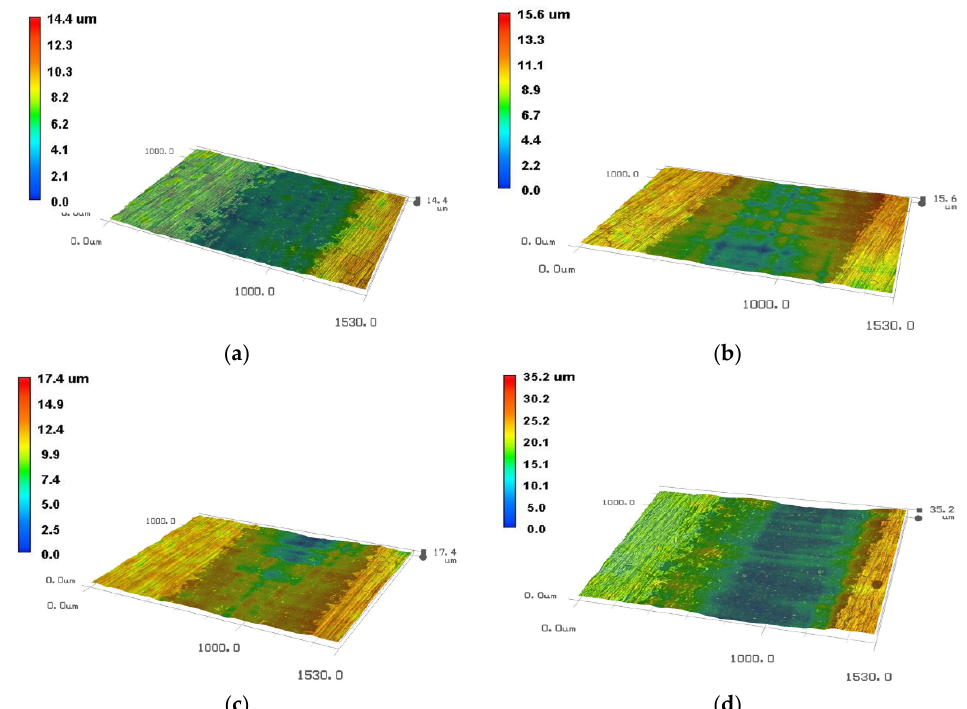
Figure 6. The micromorphologies of the solid solution enhancement 90° sample at different times. ( a ) 150 min; ( b ) 270 min; ( c ) 330 min; ( d ) 390 min.